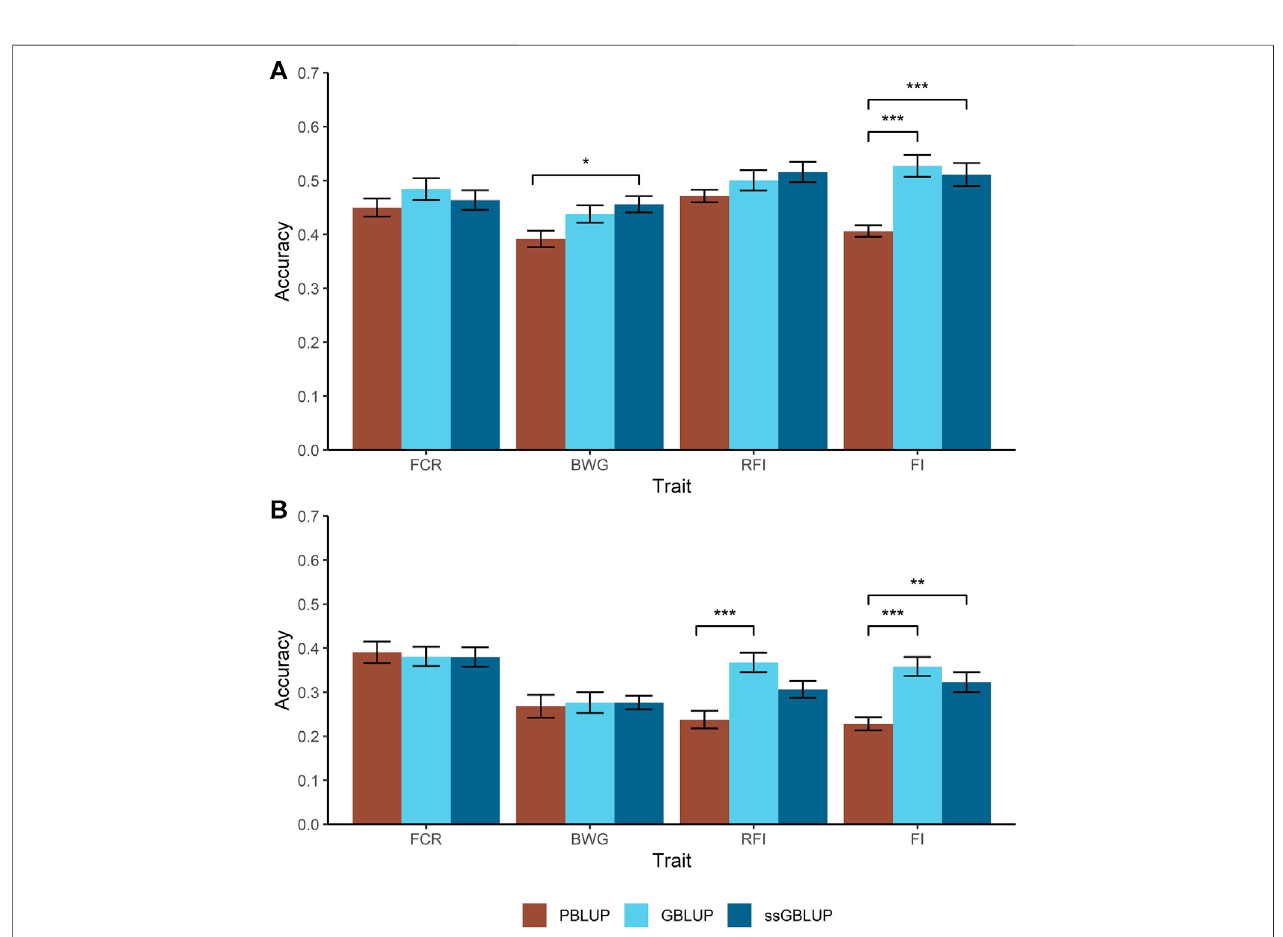
FIGURE2| Predictedaccuraciescomparisonforthefeed-ef fi ciencyrelatedtraitsinaNiletilapia( Oreochromisniloticus )breedingpopulation.Accuraciespredicted throughpedigree-based BLUP(PBLUP),genomicBLUP(GBLUP)andsingle-stepGBLUP(ssGBLUP)forfeedconversion ratio(FCR),bodyweightgain(BWG),residual feed intake (RFI) and feed intake (FI) using a random animal (A) and random family (B) cross-validation approach. The standard error for each trait and method is represented by the black bars. * (cid:2) p < 0.05; ** (cid:2) p < 1 × 10 − 3 ; *** (cid:2) p < 1 × 10 − 5 .